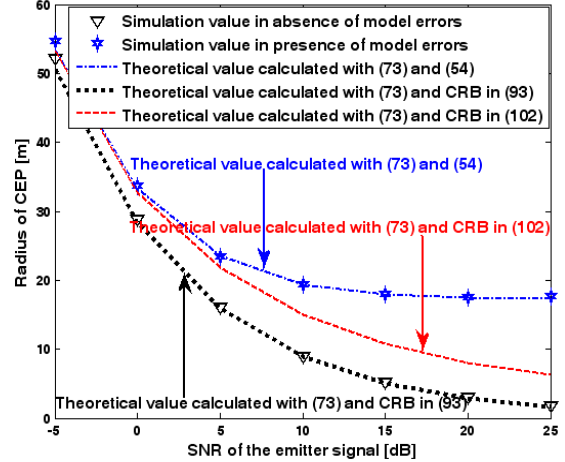
Figure 19. Radius of CEP versus SNR of the emitter signal in the first experiment.